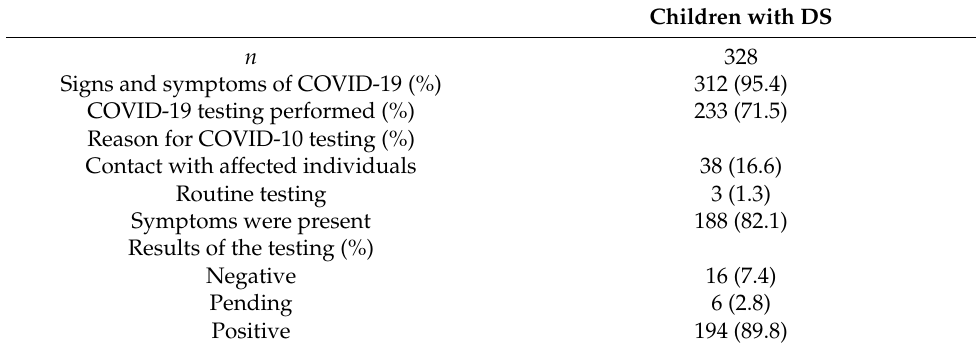
Figure A2. Data entered into the database during a later phase of the pandemic (22 October to 2 August 2021). Hospitalisation rate of children with Down syndrome and COVID-19 in low to middle-income countries (Brazil, India, Iran, Egypt, Belarus, South Africa, Mexico, Costa Rica, Bangladesh, Nepal) and high-income countries (USA, Canada, Western Europe, Argentina, Australia). Table A1. Proportion of the T21RS analysis sample with COVID-19 symptoms or positive test